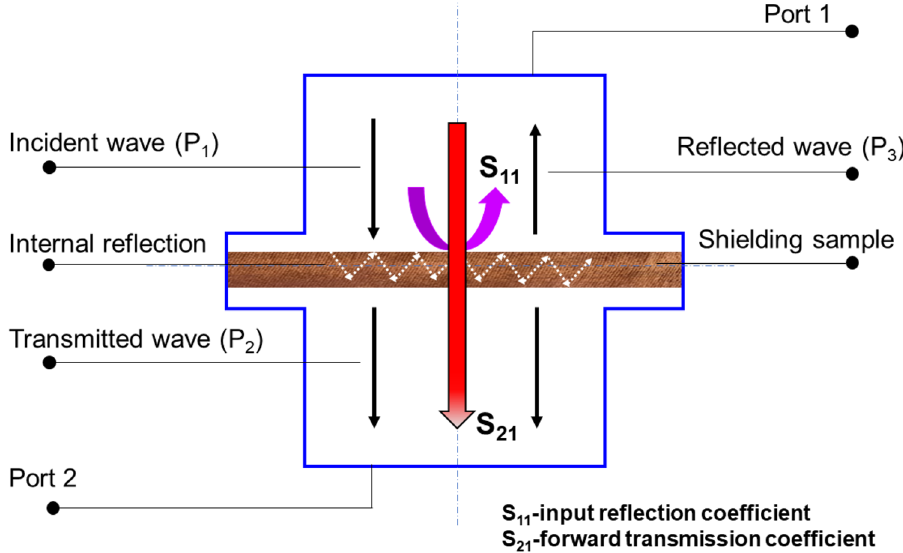
Figure 11. Measurement of SE for ultra-light Ni/Cu coated polyester fibrous